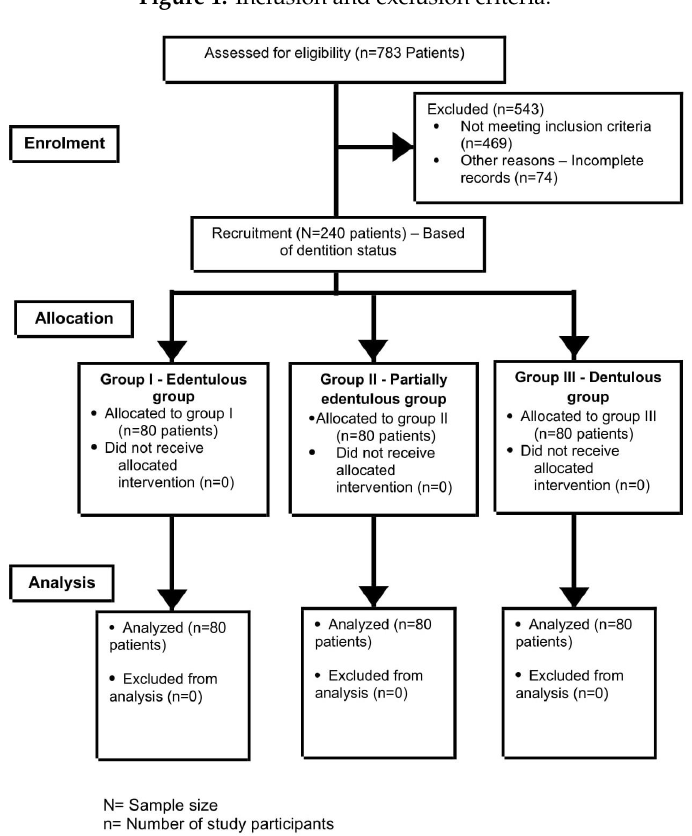
Figure 1. Inclusion and exclusion criteria. Diagnostics 2020 , 10 , x FOR PEER REVIEW